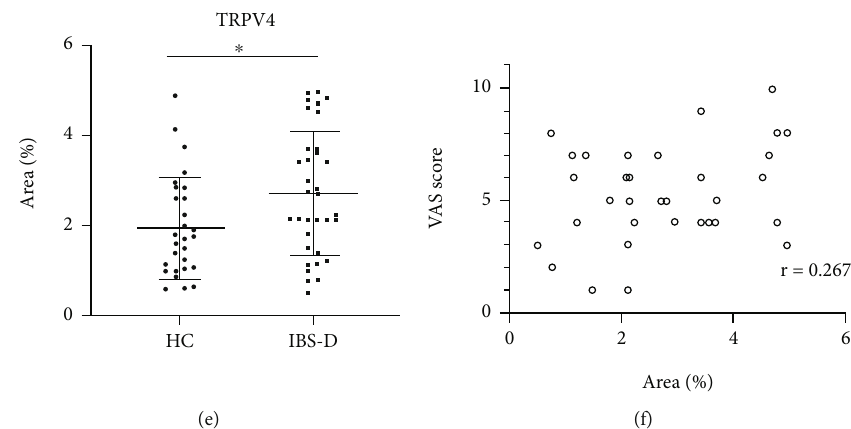
Figure 3: Expression of TRPA1 and TRPV4 was increased in the colonic mucosa of IBS-D patients and TRPA1 content correlated with the severity of the disease. (a, b) The expression of TRPA1 in the colonic mucosa of IBS-D patients was increased compared with HCs. (c) TRPA1 content correlated positively with the disease severity. (d, e) The expression of TRPV4 was enhanced in the colonic biopsies of IBS-D patients. (f) TRPV4 expression did not correlate with the disease severity. Scale bar, 50 μ M. ∗ p < 0 : 05 , ∗∗ p < 0 : 01 .